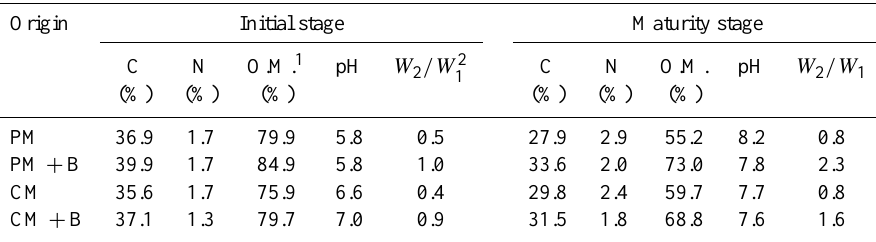
Table 2. Physical and chemical properties in poultry manure compost (PM), poultry manure blended with biochar (PM + B), cow manure (CM), and compost blended with biochar (CM + B).